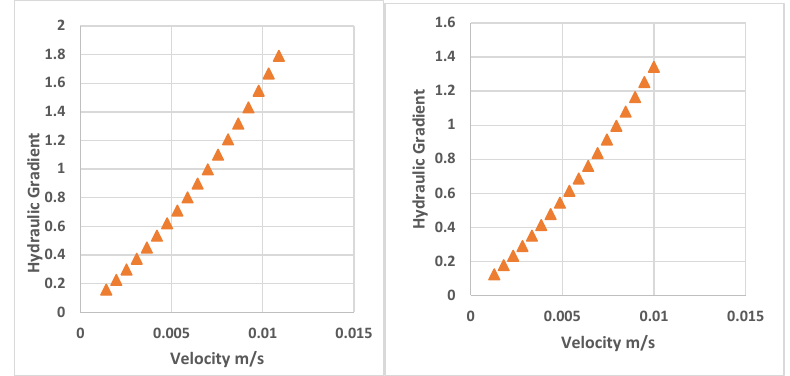
Figure 6. Hydraulic Gradient vs. Velocity for samples 5 and 6.